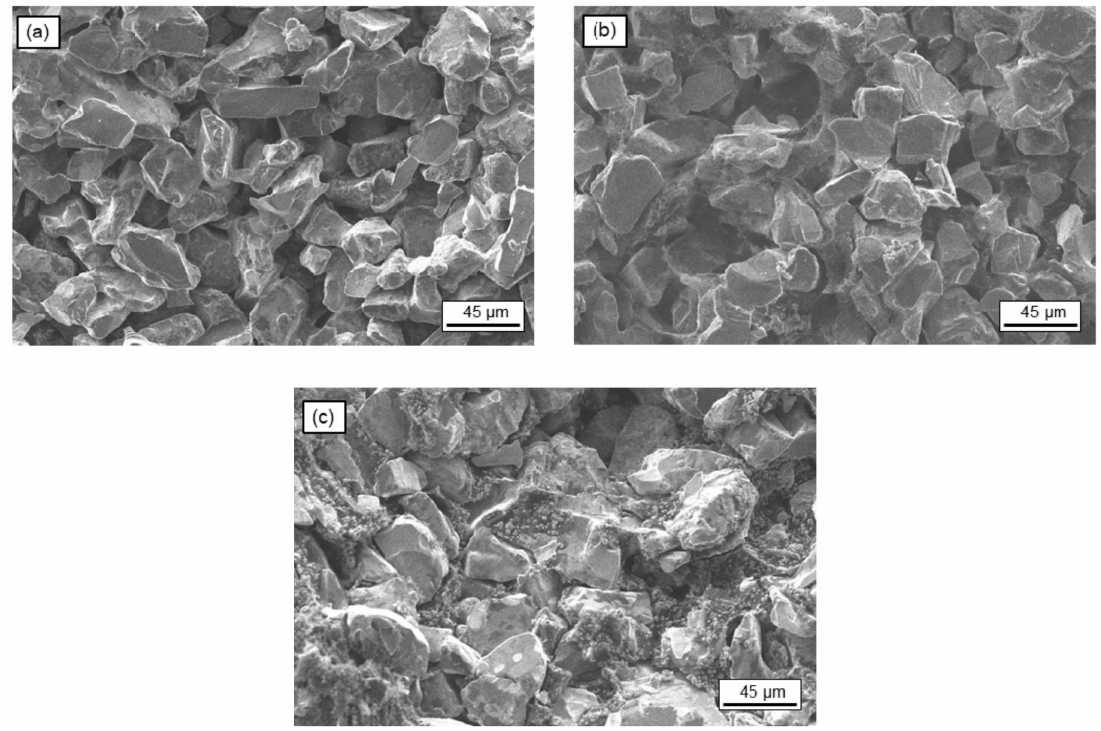
Figure 6. SEM images of the cross-section of the monoliths as a function of the sintering temperatures: ( a ) at T ◦ C, ( b ) at T-100 ◦ C, and ( c ) at T-200 ◦ C. (T ◦ C—the highest sintering temperature, confidentiality